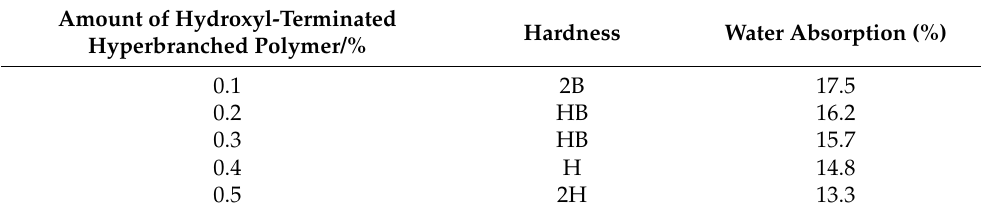
Table 4. Effect of terminal hydroxyl hyperbranched polymer content on the hardness. Amount of